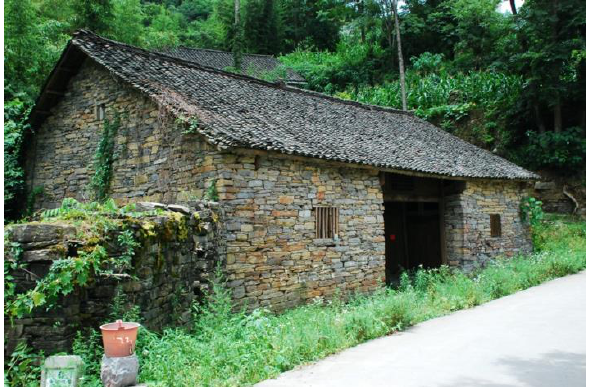
Figure 10. The Swallow Mouth Houses.